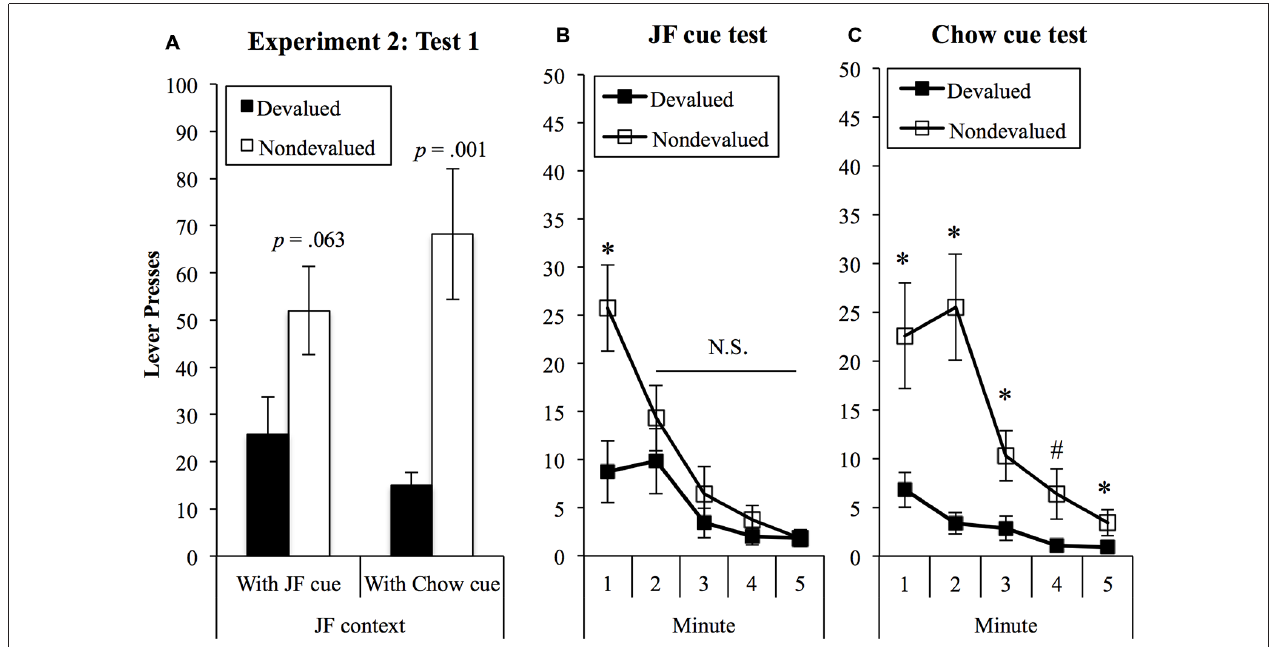
FIGURE 7 | Devaluation tests in the JF contexts. (A) Sensitivity to devaluation in the JF context was significantly improved when the chow cue was presented (interaction p = 0.038). p -values show tests of simple effects in each cue test. Analysis of bin data showed that sensitivity was lost rapidly in the presence of the JF cue (B) but remained statistically significant throughout the chow-cue test (C) . ∗ p < 0.05; # p =